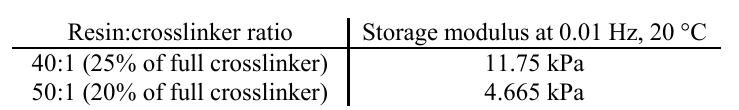
Table 1. Materials